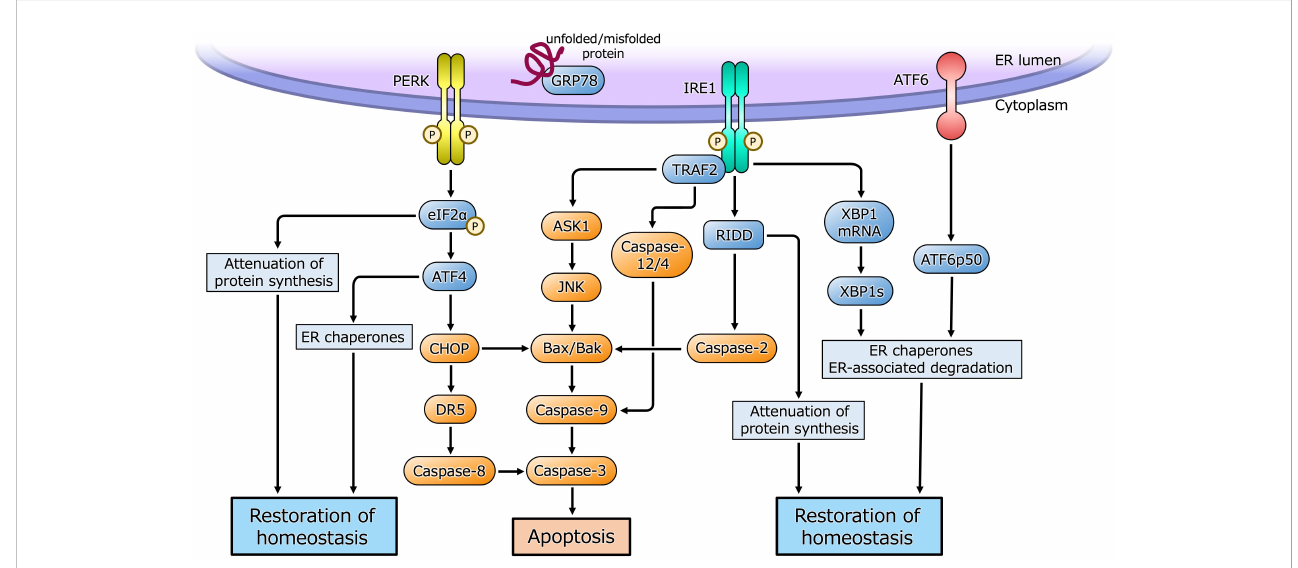
FIGURE 1 ER stress and the UPR pathway. Under ER stress, three sensor proteins located in the ER membrane are activated. Double-stranded RNA-activated protein kinase (PKR)-like ER kinase (PERK) and inositol requiring enzyme 1 (IRE1) are maintained in an inactive state by interaction with the ER chaperone glucose-regulated protein 78 (GRP78), and are activated by dimerization and self-phosphorylation when GRP78 binds to unfolded or misfolded proteins in the ER and is released from PERK and IRE1. PERK phosphorylates eukaryotic initiation factor 2 a (eIF2 a ) that causes translational arrest of most proteins to reduce overload of protein folding in the ER while facilitates translation of activating transcription factor 4 (ATF4). ATF4 induces the transcription of its target genes encoding factors involved in the ER chaperones, amino acid biosynthesis, oxidative stress response and apoptosis. CHOP induced by ATF4 activates apoptotic cascade through the induction of DR5 or Bcl-2-associated X protein (Bax)/Bcl-2 homologous antagonist/killer (Bak). IRE1 is activated by dimerization and self-phosphorylation causing X-box-binding protein 1 (XBP1) mRNA splicing via its endoribonuclease activity. Spliced XBP1 (XBP1s) protein induces transcription of UPR target genes involved in the ER chaperones, ER-associated degradation and cell homeostasis. IRE1 also cleaves ER- associated mRNAs and non-coding functional RNAs, resulting in their degradation through regulated IRE1-dependent decay (RIDD), which reduces protein folding load in the ER or activates apoptotic cascade. IRE1 also binds to adaptor protein, tumor necrosis factor receptor-associated factor 2 (TRAF2), and activates apoptotic cascade through c-Jun N-terminal kinase (JNK) or caspase-12/4 signaling. Activating transcription factor 6 (ATF6) is activated by sequential cleavage in Golgi apparatus, releasing its active fragment, ATF6p50, which induces transcription of UPR target genes involved in the ER chaperones, ER-associated degradation and cell